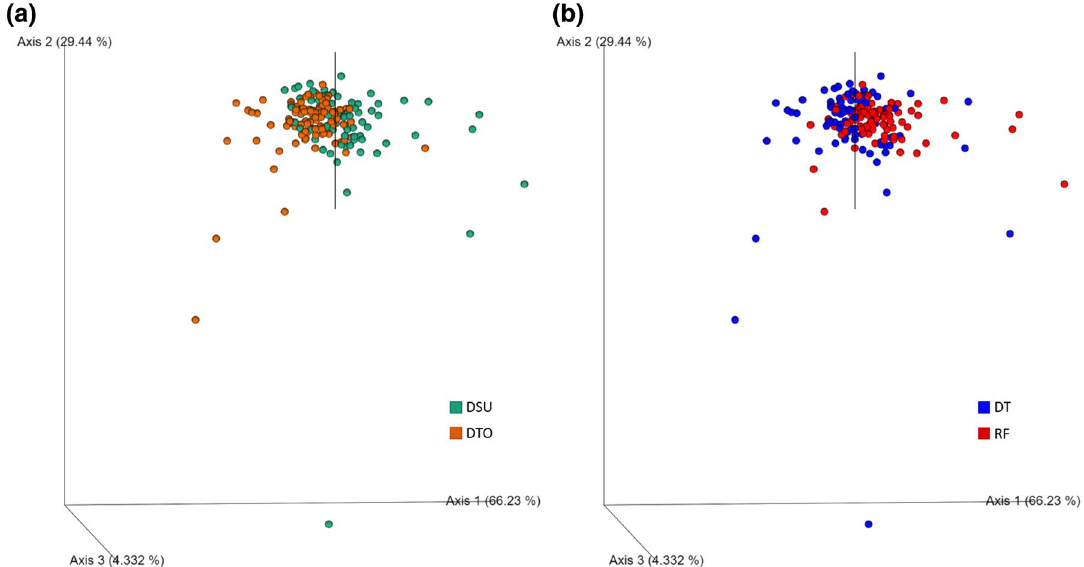
Figure 2. RPCA of the seed microbiomes of wheat lines ( a ) subjected to drought conditions (DT) or rainfed conditions (RF) (PERMANOVA pseudo- F = 21.0, p = 0.001) ( b ) from drought tolerant lines (DTO) or drought susceptible lines (DSU) (PERMANOVA pseudo- F = 8.8, p = 0.001).